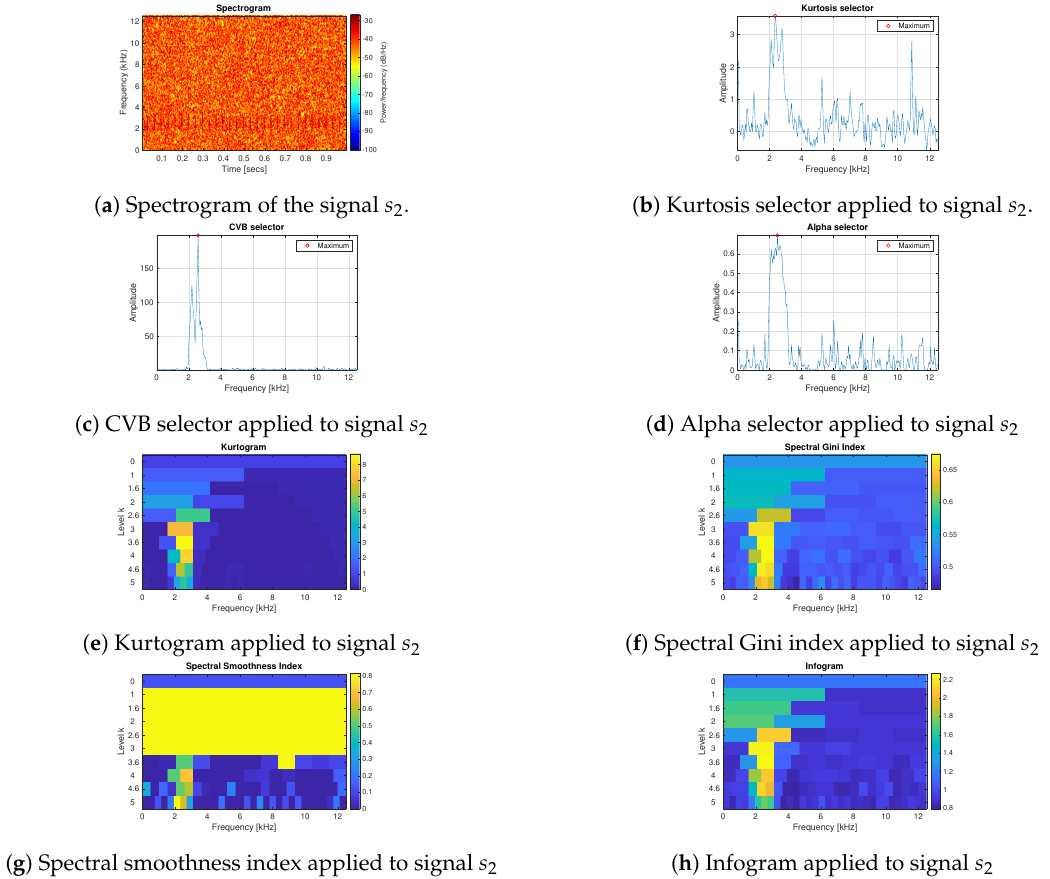
Figure 3. Results of the informative frequency band selection for 7 different methods for the signal s 2